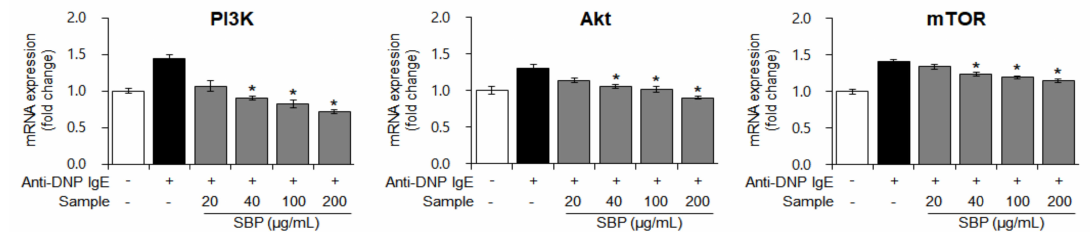
Figure 7. Effect of the SBP extract on mRNA expression of PI3K/mTOR in RBL − 2H3 cells. Data are expressed as mean ± SEM. Significantly different from the LPS-treated group (* p < 0.05). SBP, sword bean pod. PI3K, phosphoinositide 3-kinases; Akt, protein kinase B; mTOR, mammalian target of rapamycin. 3.8. Effect of SBP Extract on the Protein Expression of Th1/Th2 Differentiation Transcription Factors in RBL-2H3 Cells Stimulated by Anti-DNP IgE After confirming that the SBP extract can regulate the mRNA expression of anti- inflammatory and pro-inflammatory cytokines and suppress that of the PI3K/mTOR signaling factors that regulate T-cell differentiation, we finally investigated the mechanism of Th1/Th2 cell differentiation using western blotting. The protein expression of Th1 cell differentiation-related transcription factors p-STAT1, T-bet, and IRF1 was reduced, while the expression of Th2 cell differentiation transcription factors p-STAT6, GATA3, and c-maf was increased in the allergic group. The expression of p-STAT1, T-bet, and IRF1 increased with increasing concentrations of the SBP extract in the allergic group, while the increase in the expression of p-STAT6, GATA3, and c-maf was suppressed (Figure 8).